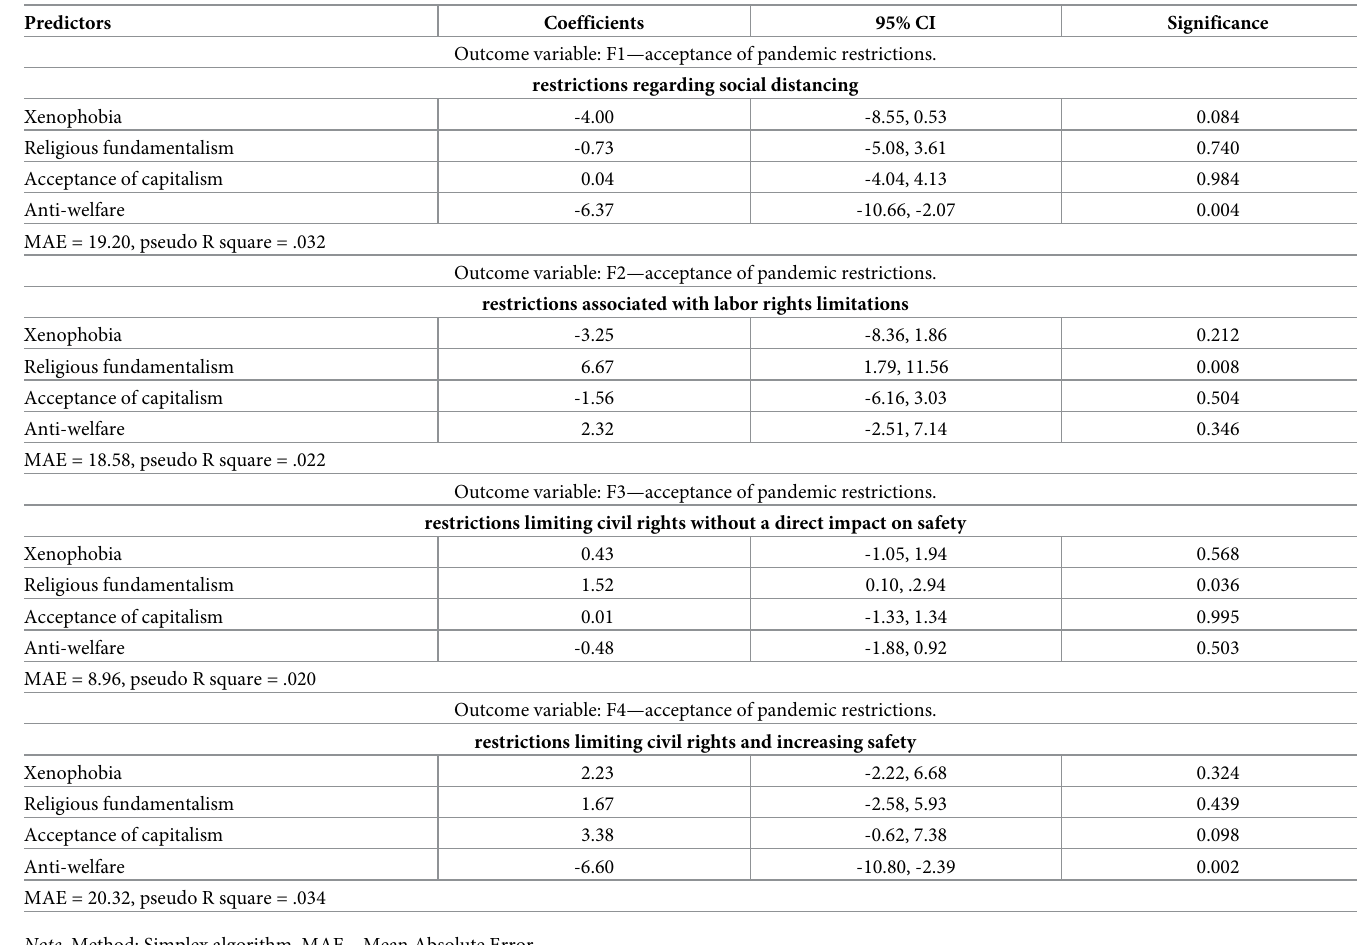
Table 4. The acceptance of the restrictions regarding social distancing (F1) and the restrictions limiting civil rights and increasing safety (F4) was (negatively) predicted by anti-welfare atti- tudes. In turn, the acceptance of the restrictions associated with the limitations of labour rights as well as those limiting civil rights without a direct impact on safety was (positively) predicted by religious fundamentalism.